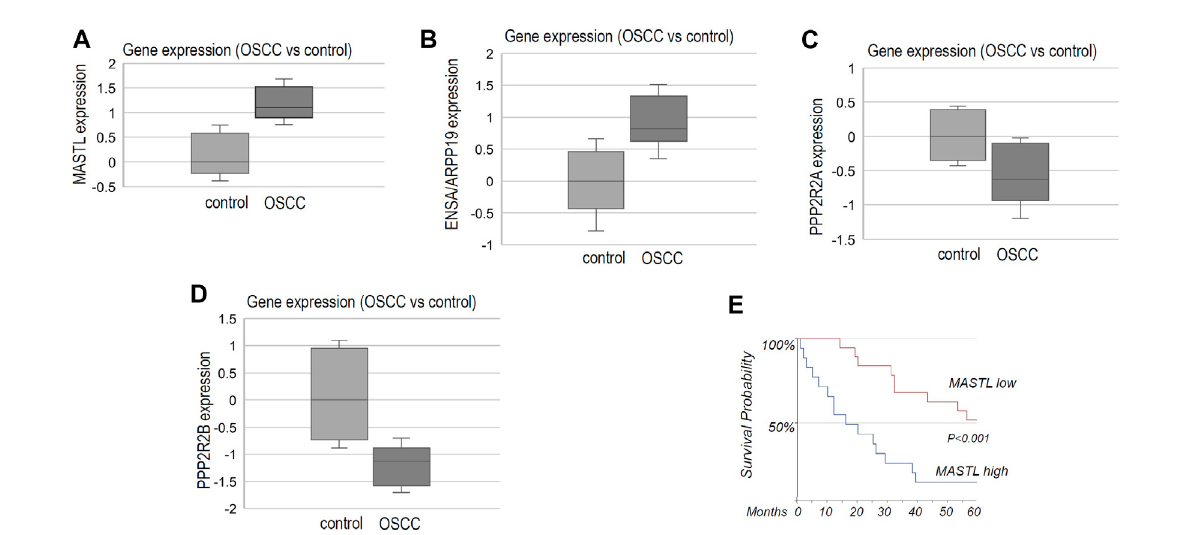
FIGURE 1 The MASTL-ENSA/ARPP19-PP2A/B55 pathway is dysregulated in OSCC, in association with patient survival. (A) The gene expression data for MASTL, ENSA, ARPP19, PPP2R2A and PPP2R2B were obtained, as described in Materials and Methods. The expression level of MASTL in control (normal, n = 44) or OSCC tumor tissues ( n = 114) was shown in the box plot diagram (in log2 scale). (B) The expression level of ENSA + ARPP19 in control (normal, n =53)orOSCCtumor tissues( n =137)wasshown inthebox plotdiagram(in log2 scale). (C) The expressionlevel ofPPP2R2A incontrol (normal, n = 39) or OSCC tumor tissues ( n =132) was shown inthe box plotdiagram (in log2 scale). (D) The expressionlevel of PPP2R2B in control (normal, n =48) orOSCCtumor tissues( n =89) wasshown inthebox plotdiagram (inlog2 scale). (E) AsdescribedinMaterials andMethods, OSCC tumor samples were obtained for 35 HPV- oral patients who were treated at the University of Nebraska Medical Center. Immunohistochemistry wasperformedtodetectMASTLexpression.Thesurvivalprobabilitywasshownforpatientswithhighorlowlevels ofMASTL